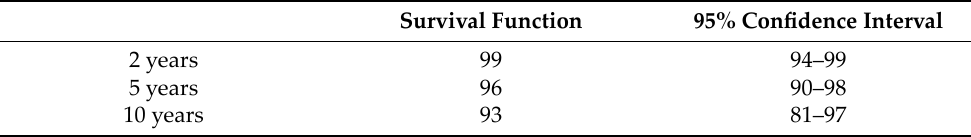
Figure 1. Kaplan–Meier Overall Survival Curve. Table 4. Overall Survival: Kaplan–Meier Survival Estimation. Table 4. Overall Survival: Kaplan–Meier Survival Estimation.